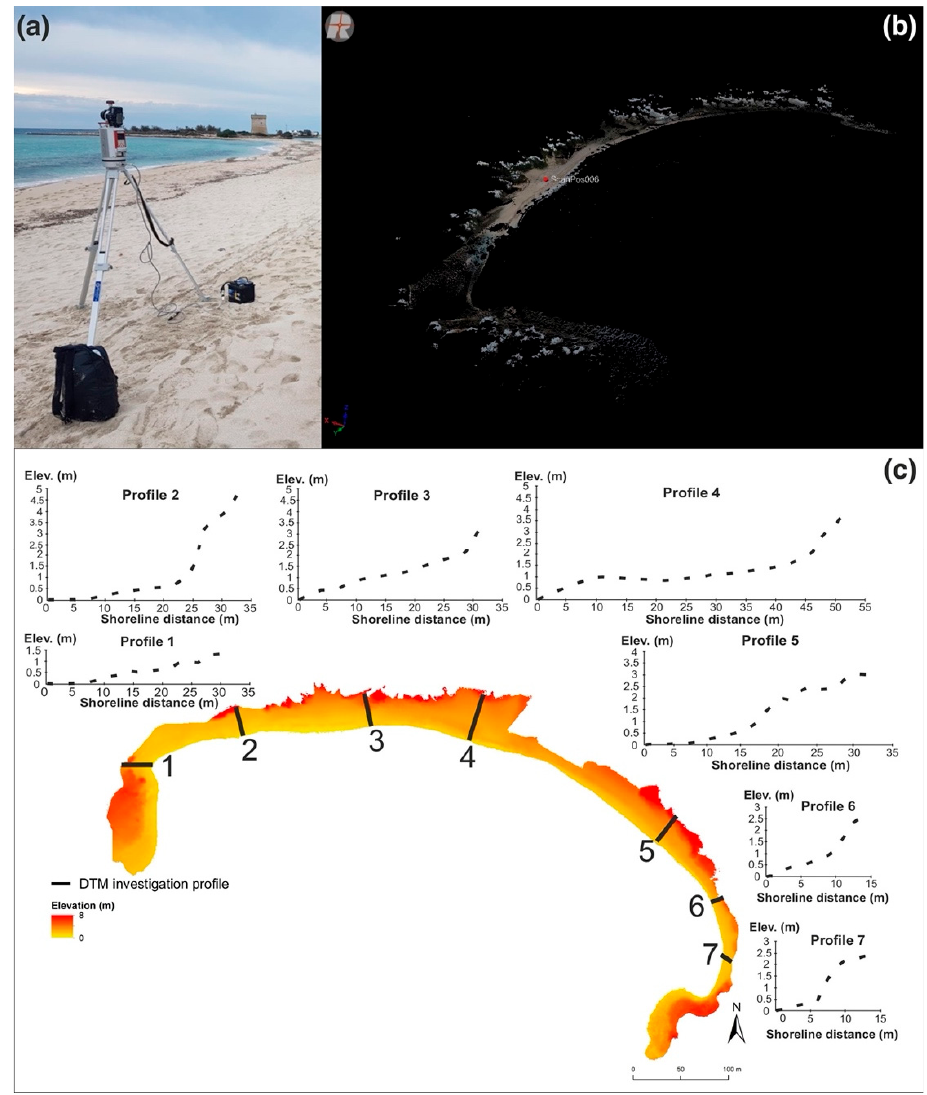
Figure 8. Emerged beach topography investigation. ( a ) TLS Riegl VZ-400 instrument during a survey campaign; ( b ) Example of a point cloud during a scan registration with Riscan Pro software: the red point represents the instrument location during the measurement acquisition; ( c ) Digital elevation model (DEM) of the emerged sector in summer 2018 processed with ArcMap © 10.1.